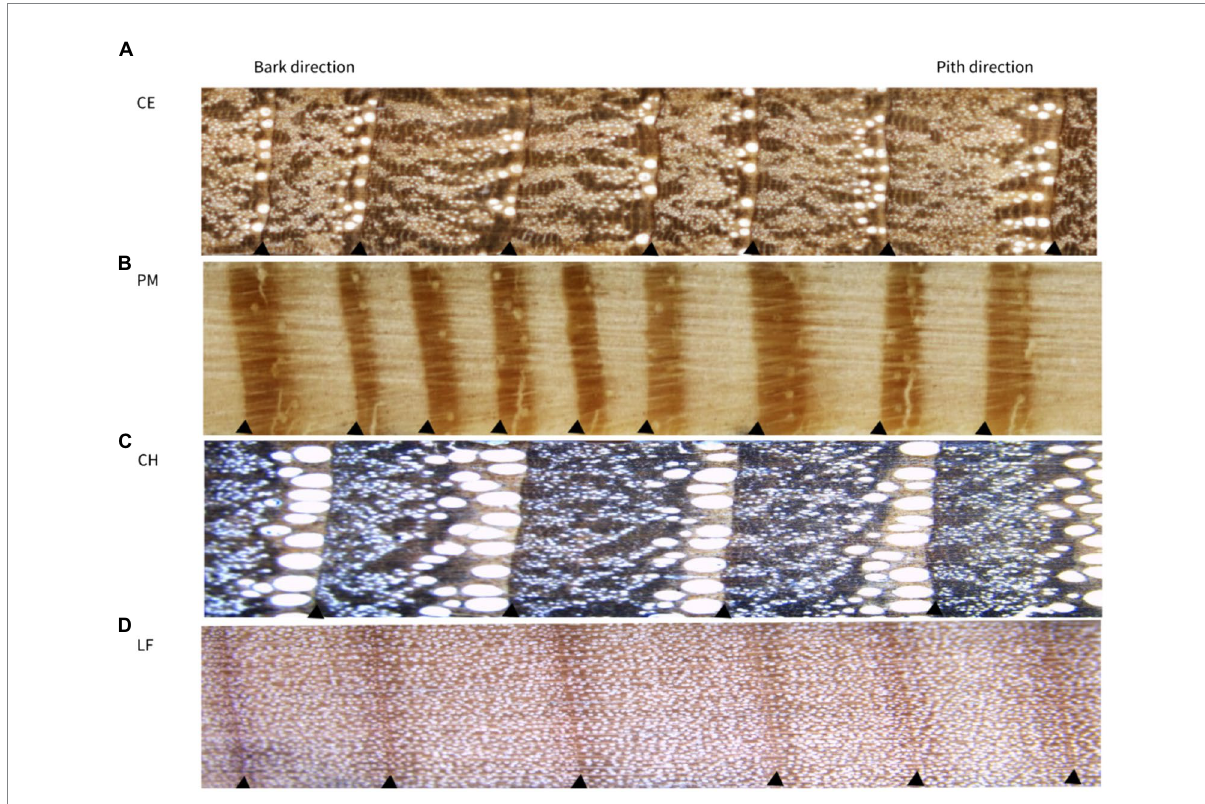
FIGURE 3 Photographs of the tree rings of the four tree species in the northern Luoxiao Mountain. (A) C. eyrei , (B) P. massoniana , (C) C. henryi and (D) L. formosana . The triangle indicates the ring boundary.